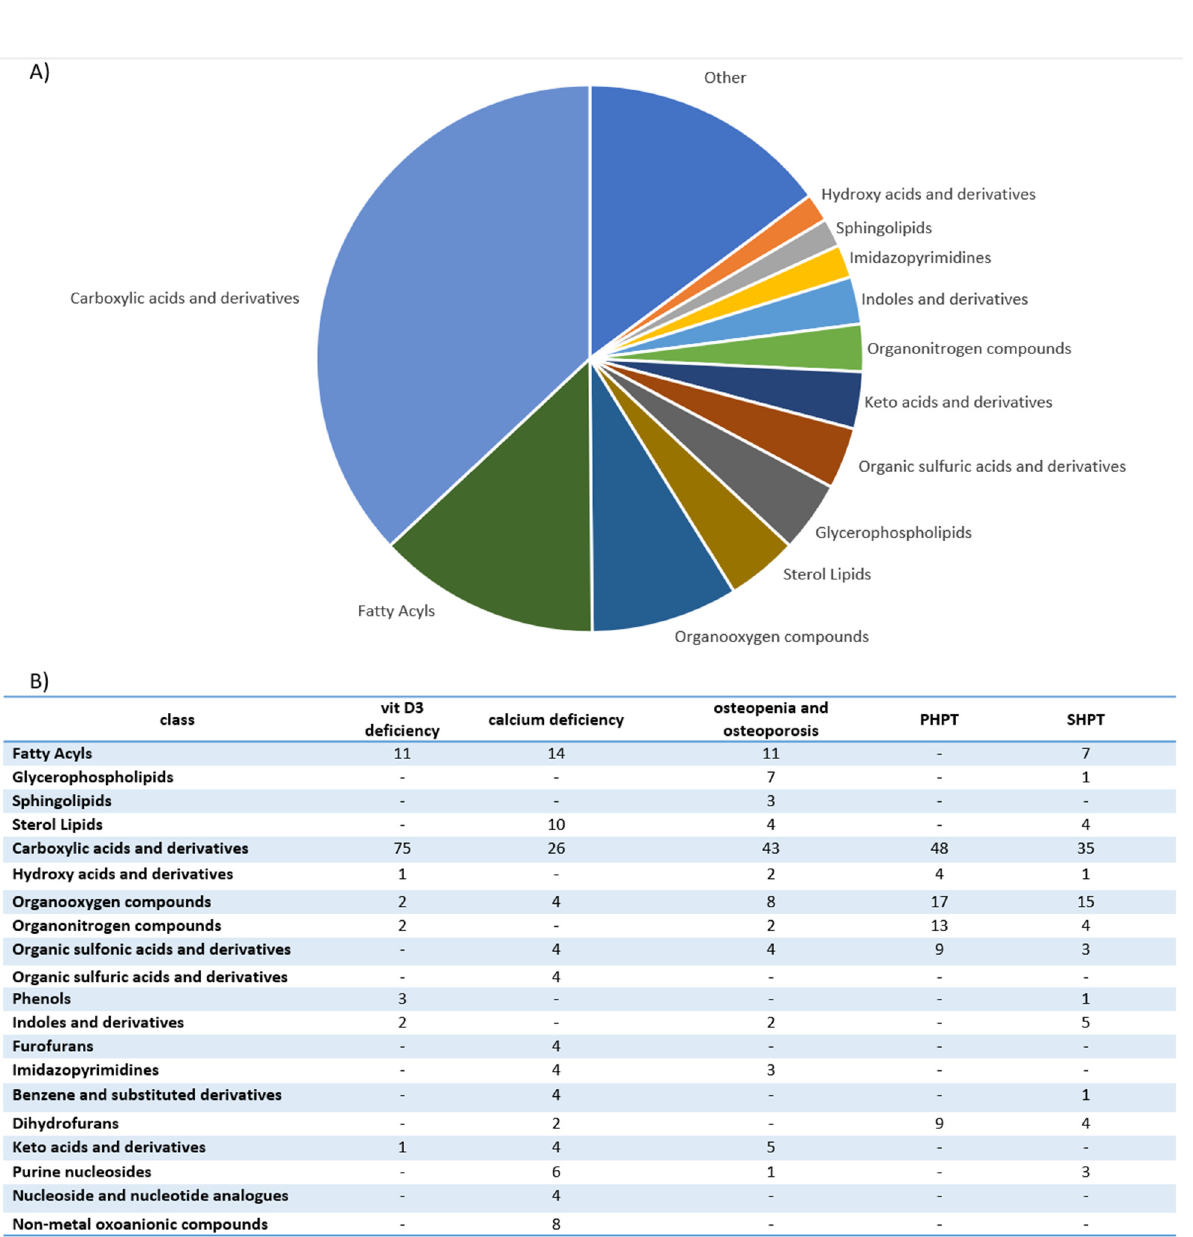
Figure 1. Metabolites altered in calcium metabolism disorders detected in metabolomics studies. ( A ) shows pie chart illustrating distribution of all metabolites across different classes, while ( B ) shows a table with distribution of metabolites across different classes with the stratification for different calcium metabolism disorders. The numbers reflect the number of metabolites assigned to the particular class.